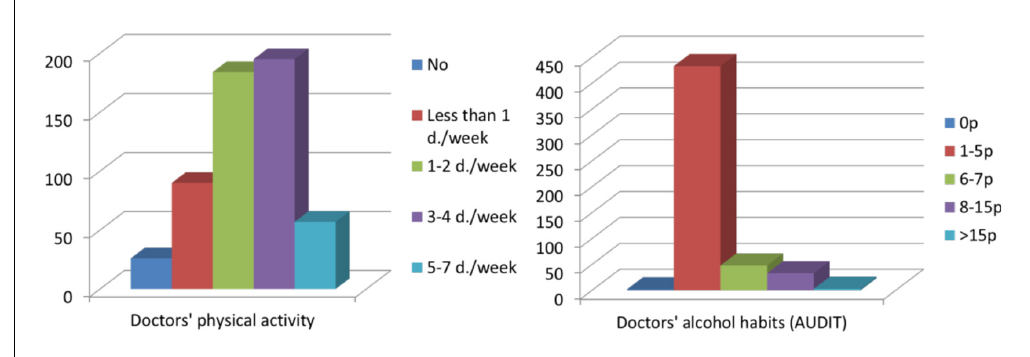
Figure 2. Doctors’ own physical activity level and alcohol habits in 2014.